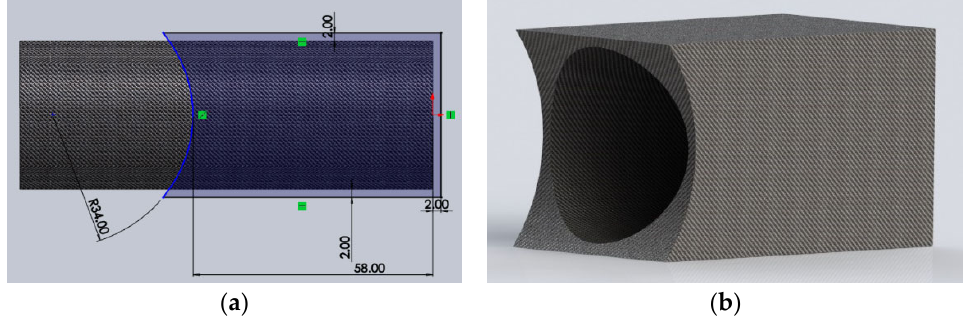
Figure 6. The waterproof casing: ( a ) creating the waterproof casing; ( b ) CAD model of the water- proof casing.